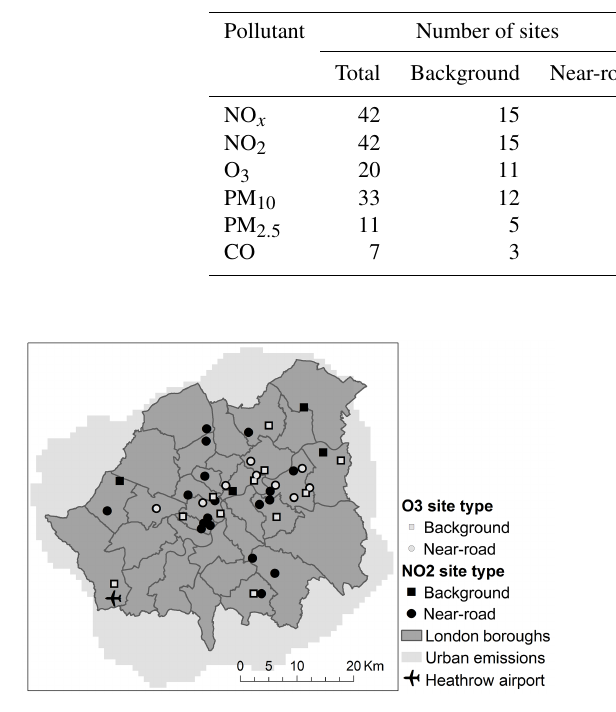
Figure 1. Locations of NO 2 (black) and O 3 (pale grey) monitoring sites in Greater London, with square symbols for background sites and round symbols for near-road sites. The London borough extents and boundaries are shown for reference, alongside the extent of the locally modelled emissions and the location of the measured mete- orological data at Heathrow